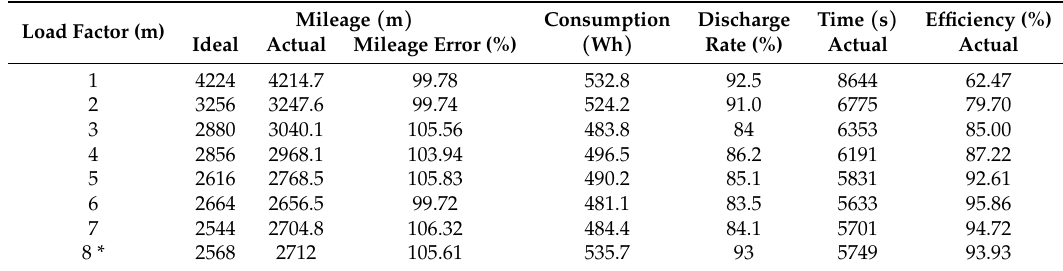
Table 5. Test results and